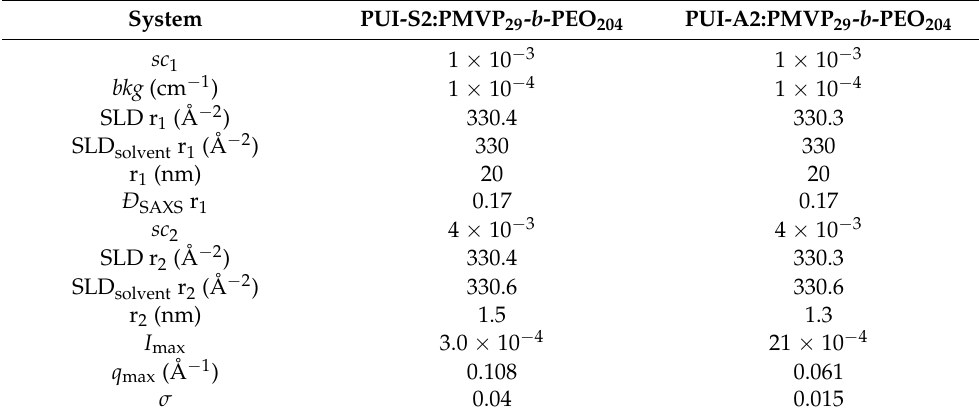
Table A1. SAXS modeling parameters: scale ( sc ), background scattering ( bkg ), scattering length den- sity (SLD), dispersity ( Ð ), and the maximum ( I max ), center ( q max ), and half-width at half-maximum ( σ ) of the Lorentzian